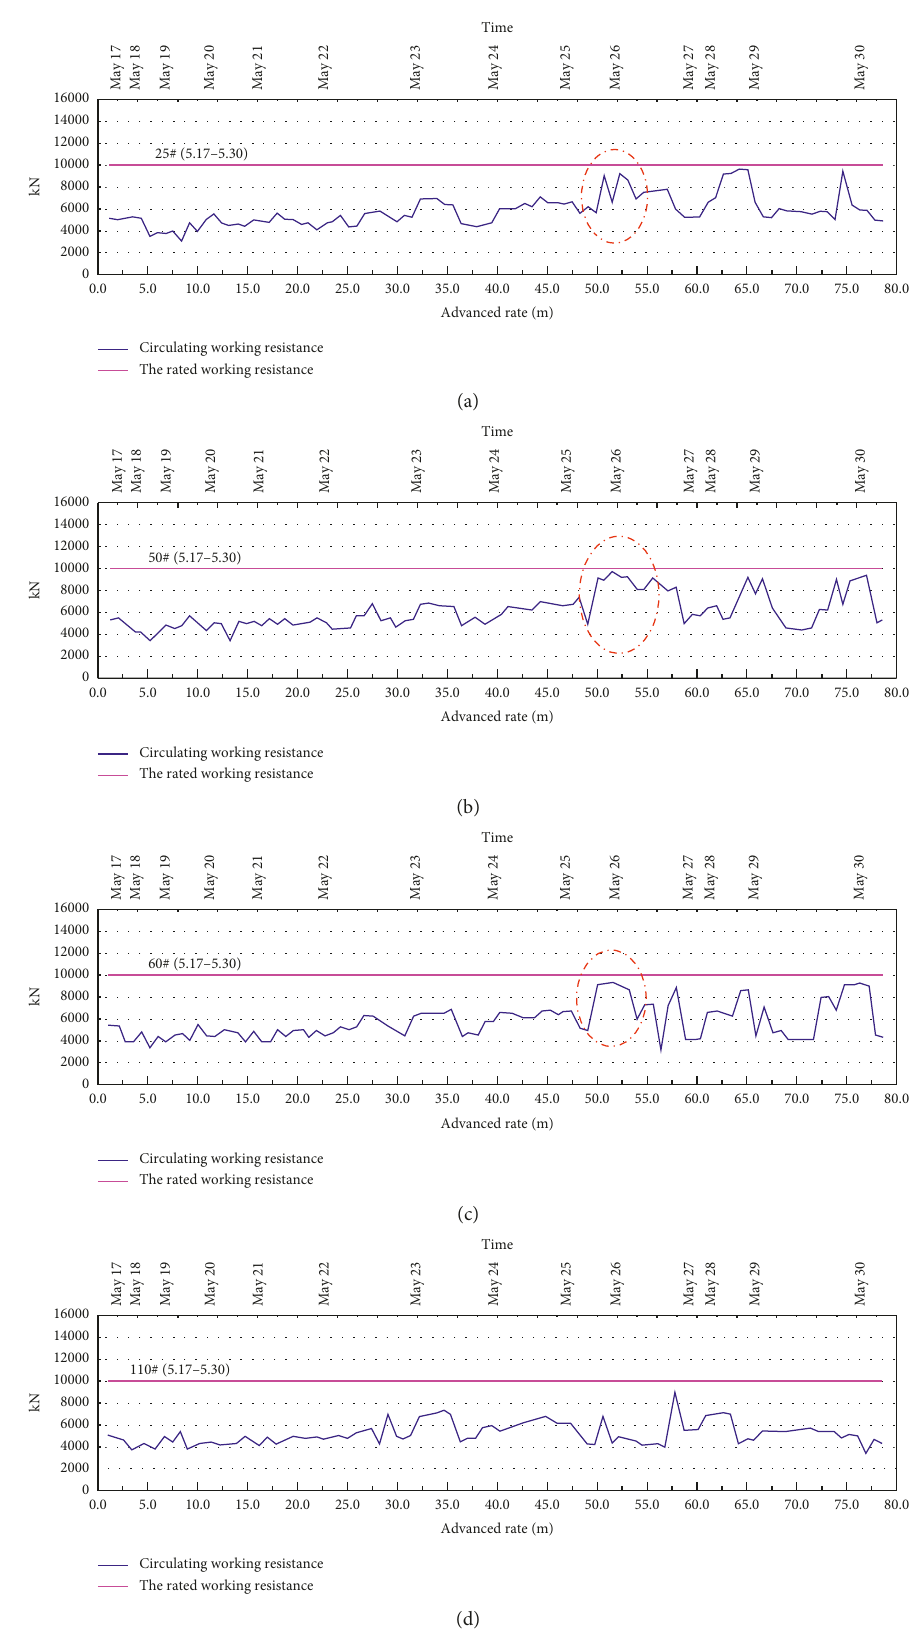
Figure 8: The working resistance distribution of hydraulic supports placed at different parts of working face at the initial mining stage. (a) 25# support. (b) 50# support. (c) 60# support. (d) 110#